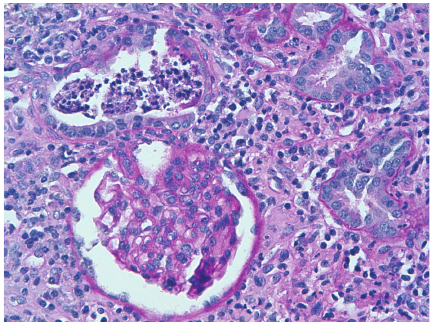
Figure 3: PAS reaction shows a tubular microabscess at the top of the picture and a normal glomerulus at the bottom. PAS